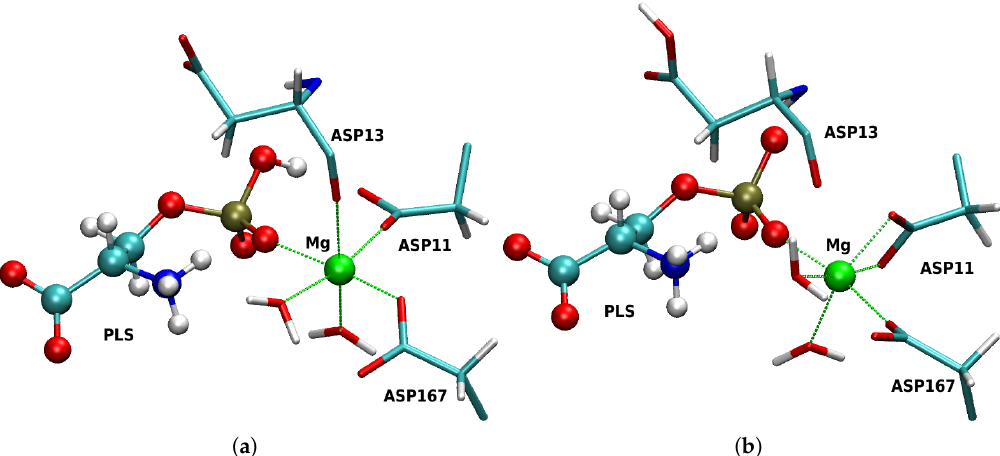
Figure 4. Snapshots from the MD simulation of the reactant state of the first phosphoryl transfer in PSP with different protonation at the scissile phosphate group: ( a ) Anionic phosphoserine. The Mg 2 + ion is coordinated by PLS, Asp167, one carboxyl oxygen atom of Asp11 and the backbone oxygen atom of Asp13. ( b ) Dianionic phosphoserine. The Mg 2 + ion coordination by the backbone oxygen atom of Asp13 is replaced by the second carboxyl oxygen atom of